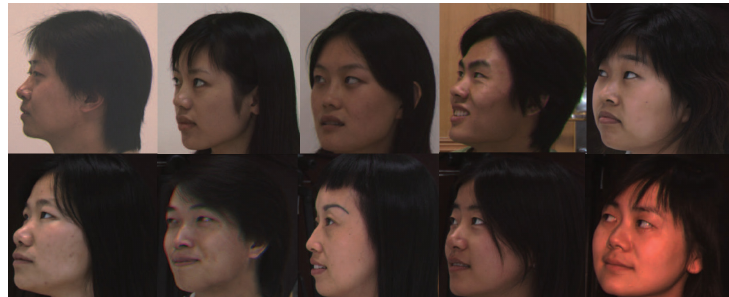
Figure 6. The 10 objects eliminated from the Chinese Academy of Sciences’ Institute of Automation (CASIA) database.